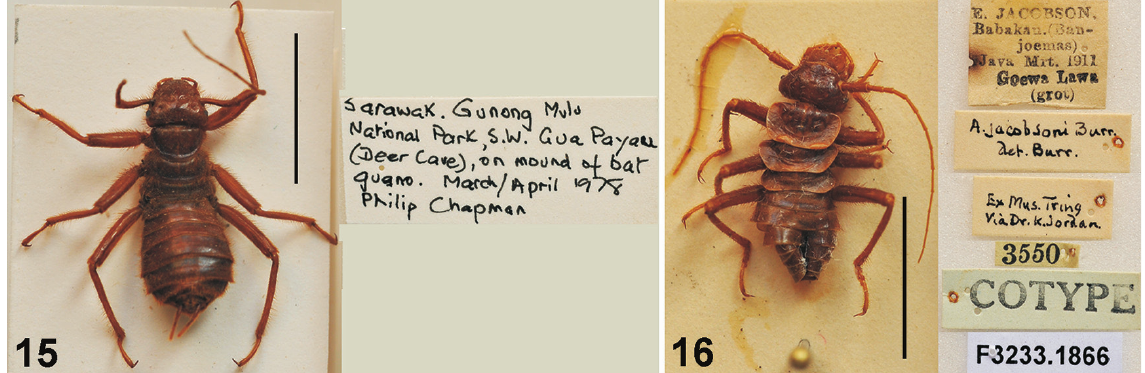
Figs 15–16. Parasitic earwigs from the collection of the Manchester Museum. 15 . Arixenia esau Jordan,